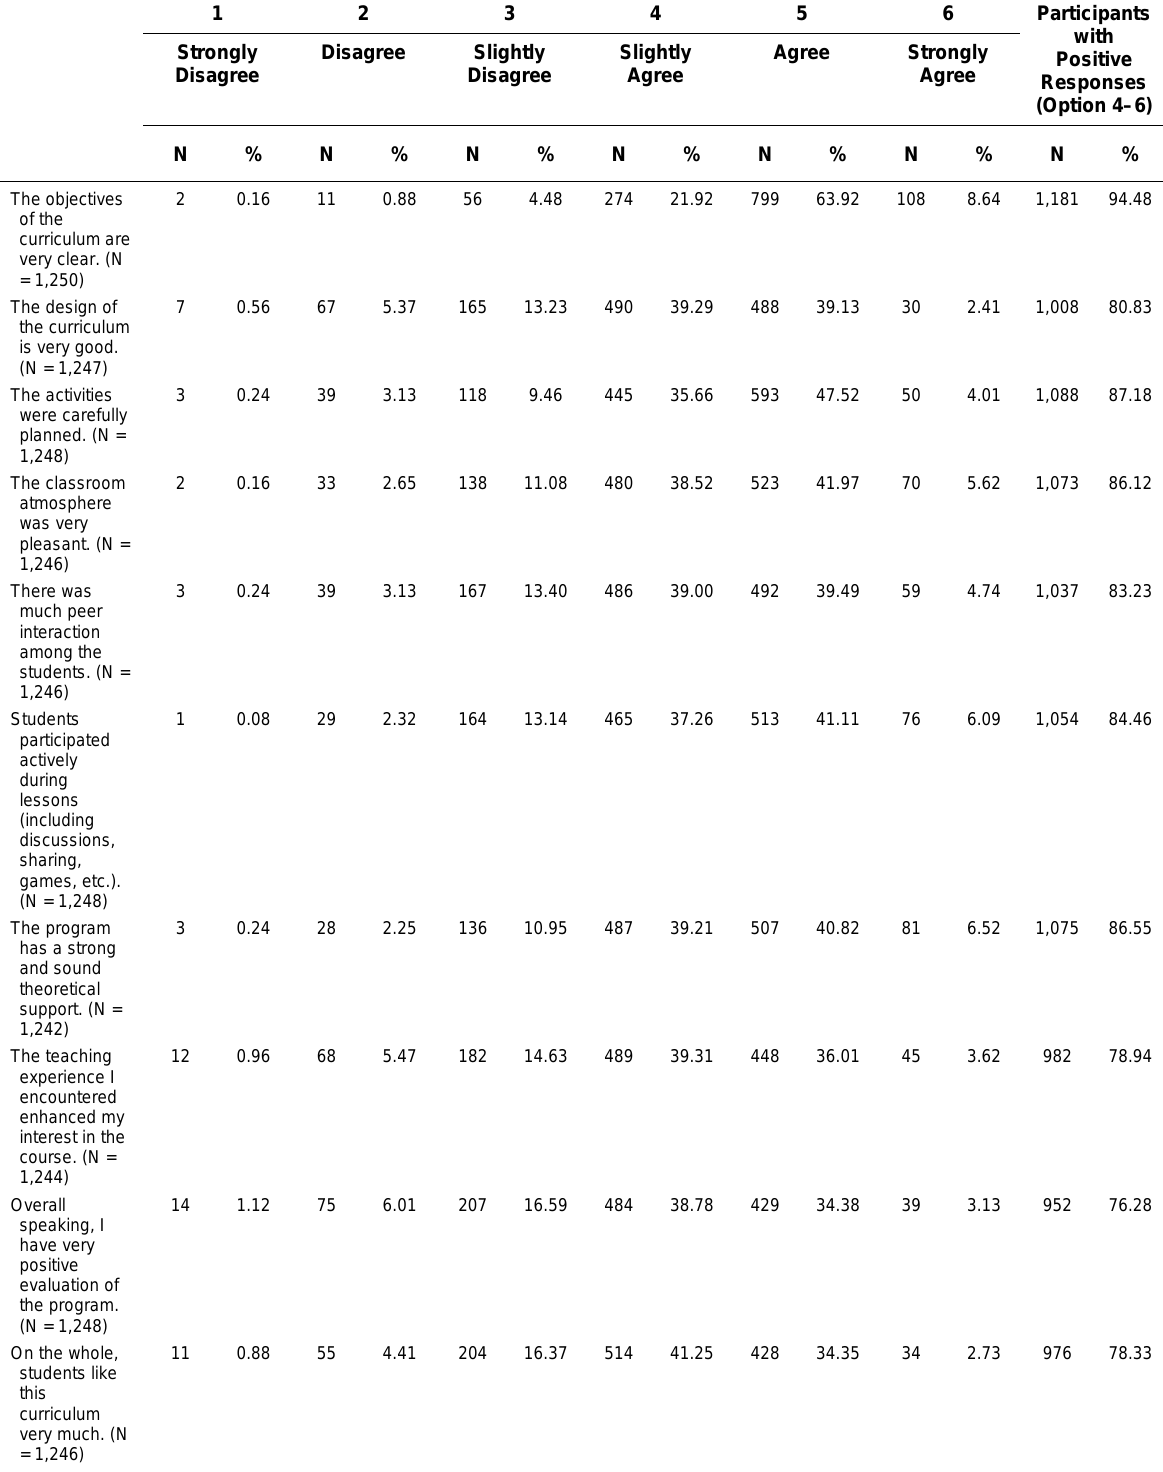
Summary of the Views of the Program Implementers About the